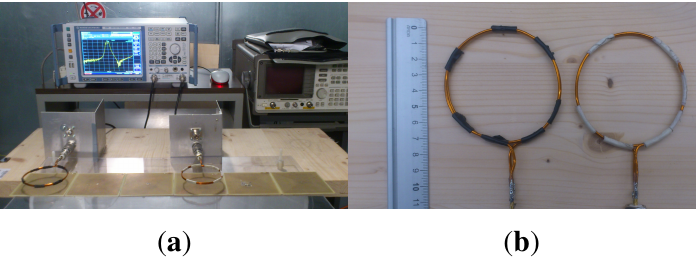
and experimental capacitance C 0 m